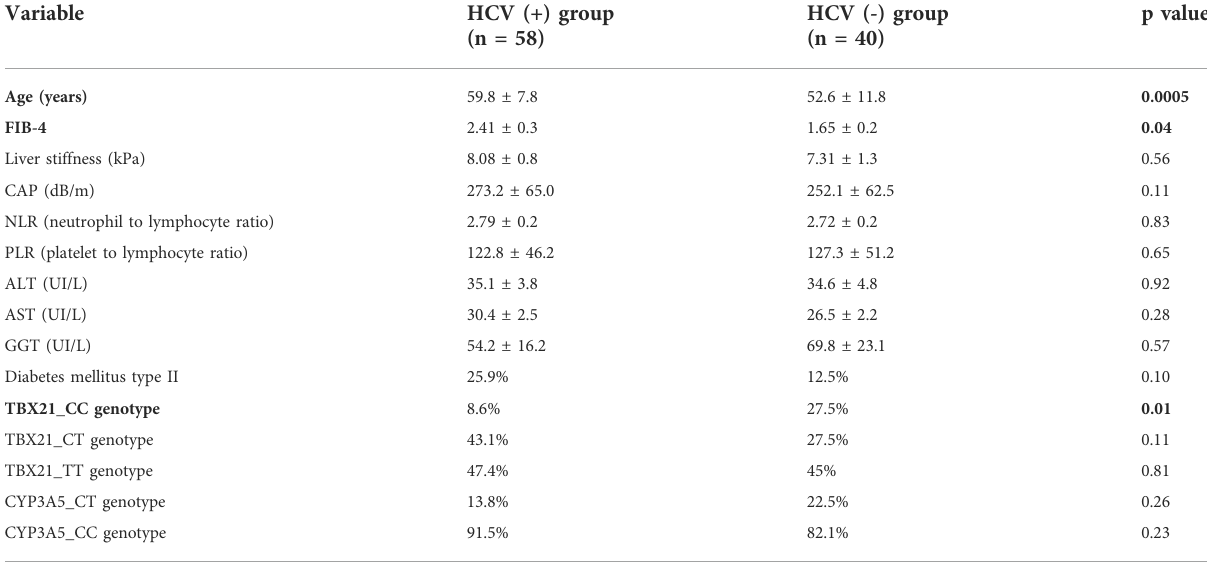
TABLE 2 Analysis of the variables in patients with cured recurrent C hepatitis after LT vs. patients transplanted for other causes of cirrhosis.